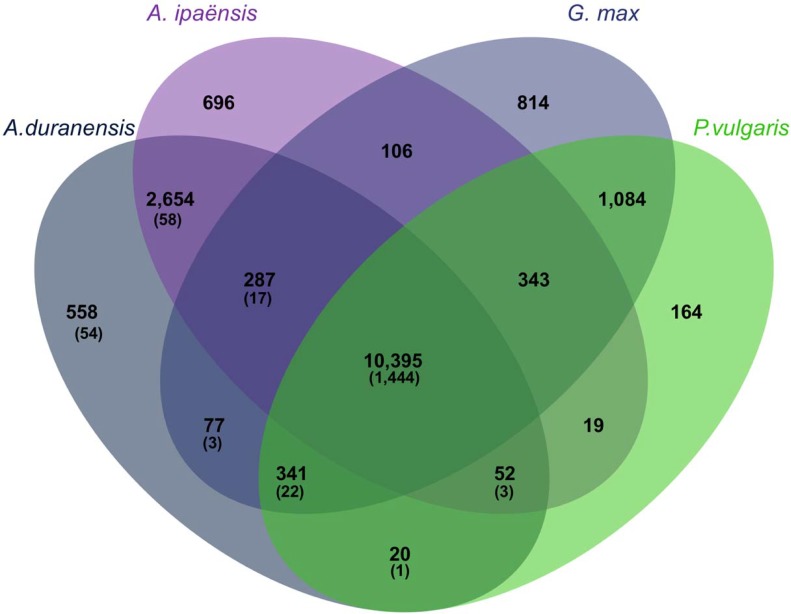
Clusters of Ortholog Groups (OGs) from four legume species.Venn diagram indicating the number of Ortholog Groups (OGs) among Arachis duranensis; Arachis ipaënsis; Glycine max; and Phaseolus vulgaris. The number of DEGs in the different groups is in parentheses.